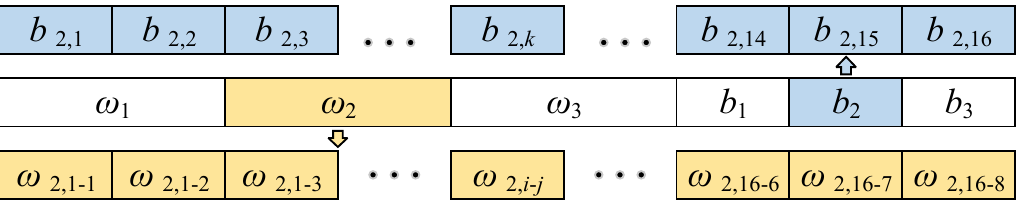
Figure 5. Real - number coding of the chromosome. Figure 5. Real-number coding of the